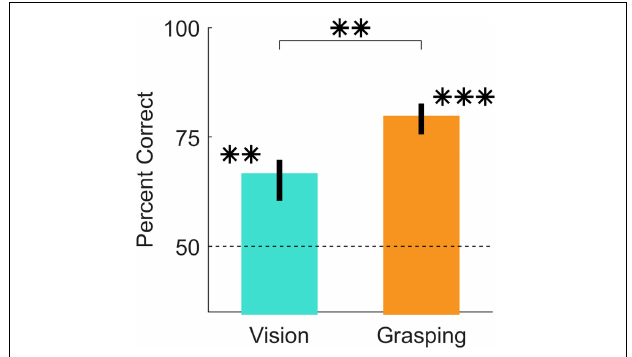
FIGURE 3 | Judgments of grasp optimality using vision and grasping. Percent correct grasp optimality judgments for the vision session (left), and the grasping session (right), averaged across objects and participants. Error bars indicate 95% bootstrapped confidence intervals of the mean. Chance performance is 50% correct (dotted line). ∗∗ p < 0.01; ∗∗∗ p <